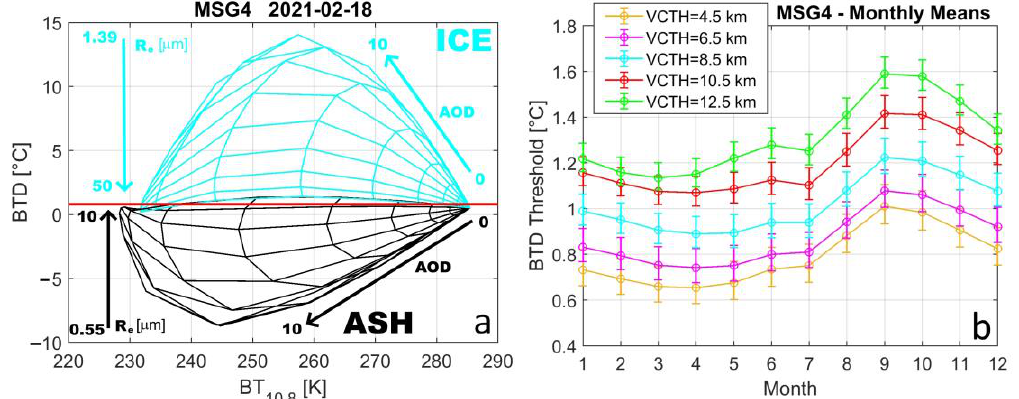
Figure 6. ( a ) Inverted arches curves of ice (cyan lines) and ash (black lines) obtained for MSG4- SEVIRI 18 February 2021 Etna LF using MODTRAN 5.3 RTM and varying AOD 0.55 and R e . The BTD threshold (BTD = 0.8) is obtained with a horizontal linear fit (red line) of the points with maximum R e . ( b ) Theoretical MSG4-SEVIRI BTD thresholds monthly variation as a function of VCTH of Etna and the VZA (identified by error